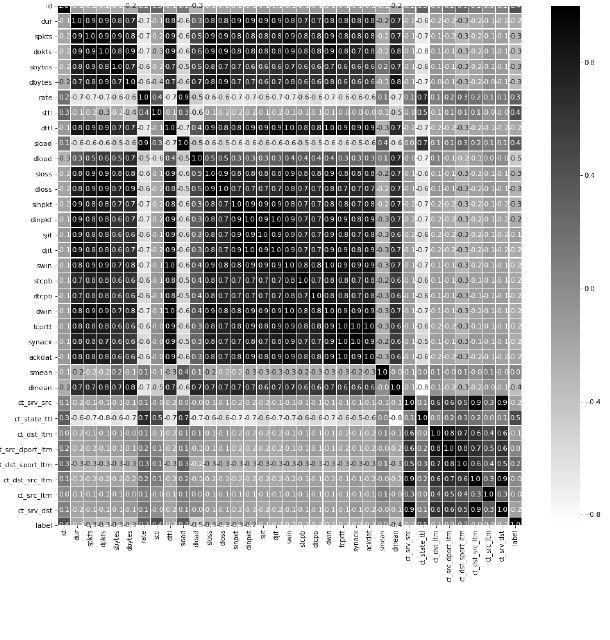
Fig 7. Joint plot between features tcprtt and ackdat